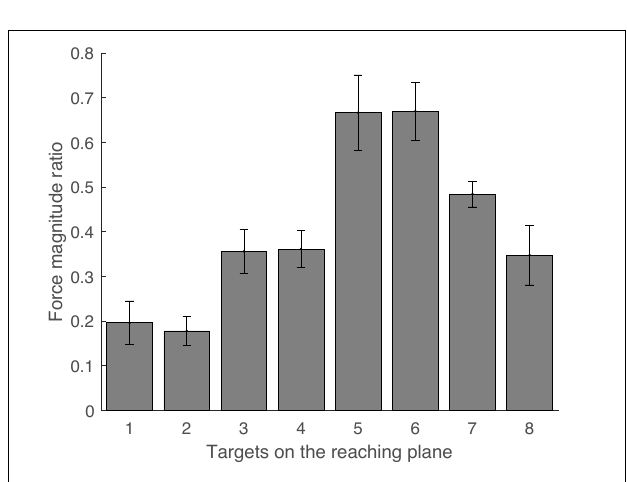
FIGURE 3 | Ratio of reference values of MVC and joint torque normalization. The reference values for EMG normalization of the MVC task and joint torque normalization were compared by dividing the reference value in the MVC task by the reference value in joint torque normalization for each muscle and every subject. The average ratio for every muscle across subjects was larger than 1. The variance of the ratio across subjects was large in trapezius, middle deltoid, biceps long head, and brachioradialis. Error bars indicate the standard error.